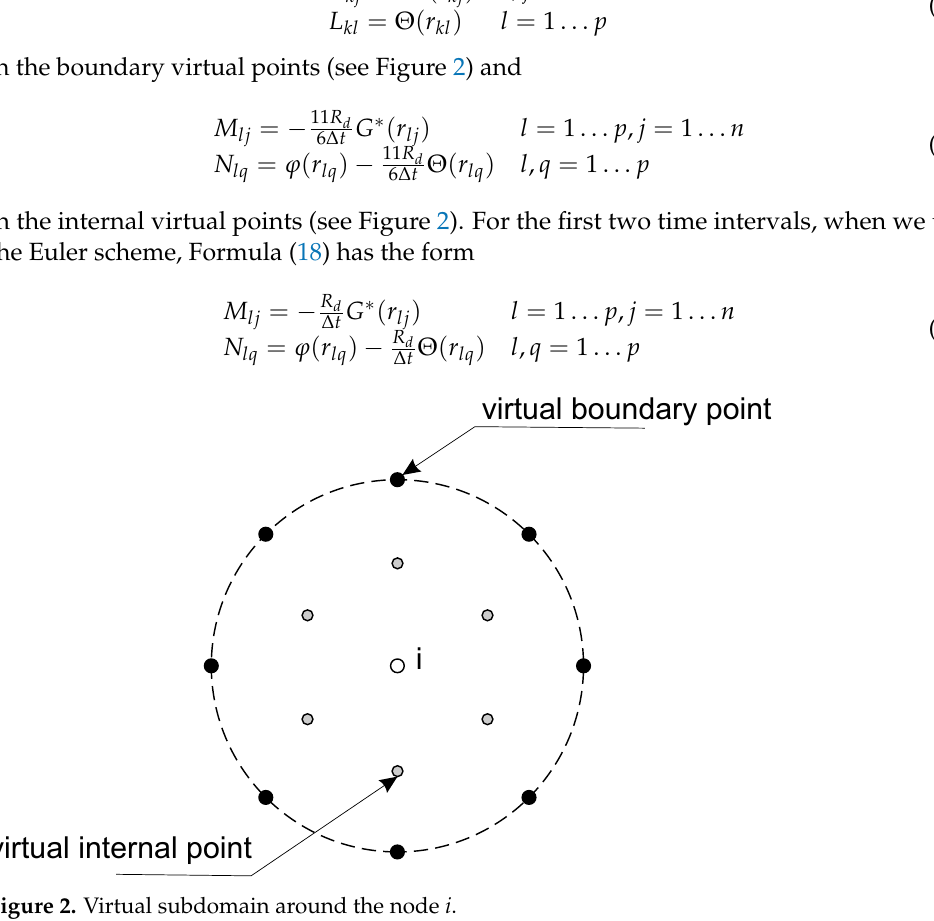
Figure 2. Virtual subdomain around the node i